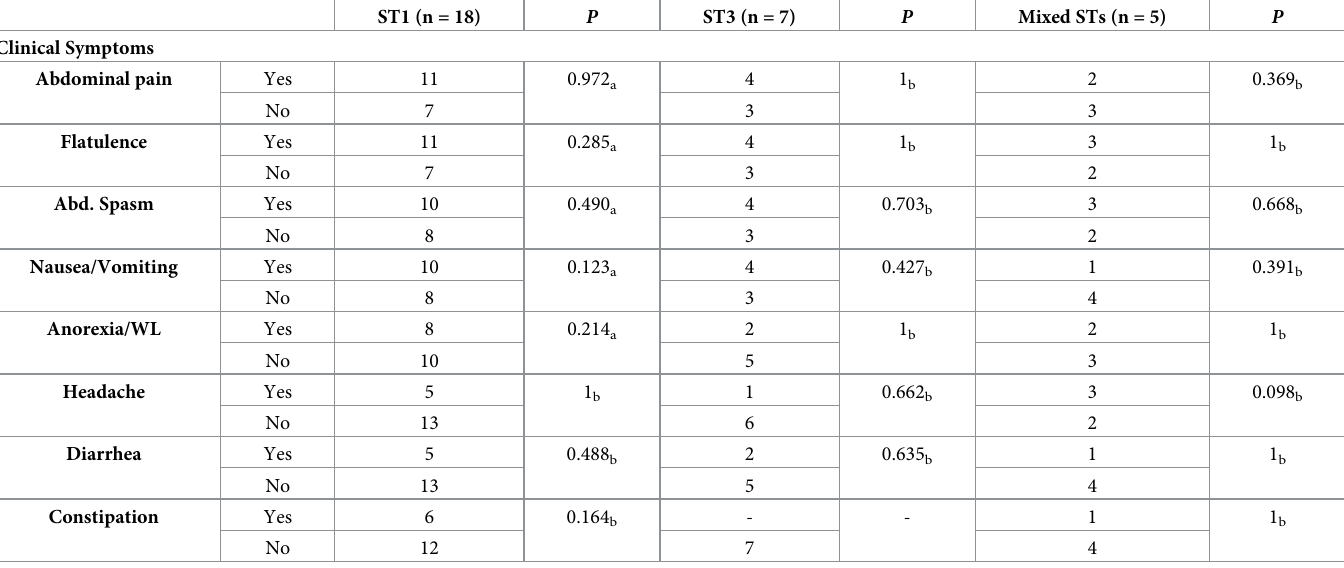
Table 5. Association between dominant Blastocystis subtypes and patients’